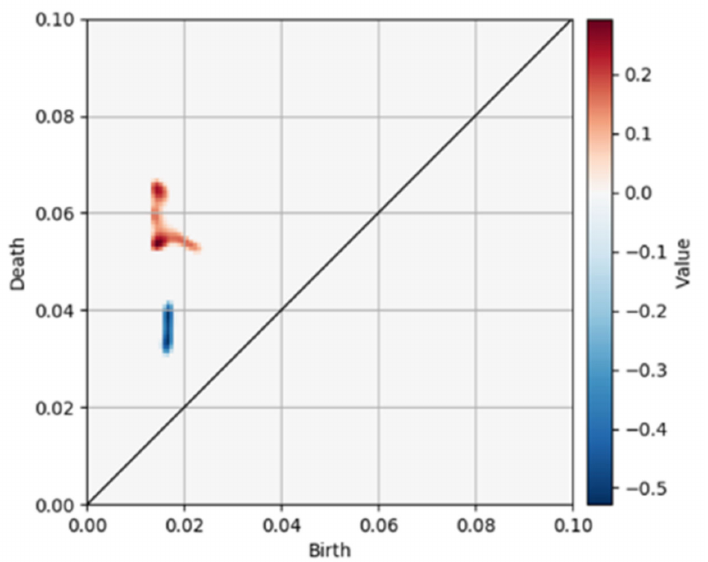
Figure 8. Distribution of the L1 regularization LR coefficient, which predicts a class from the filler morphology. The coefficient is visualized in the PD space. The red region corresponds to the positive coefficients and contributes to the positive example. The blue region corresponds to the negative coefficients and contributes to the negative